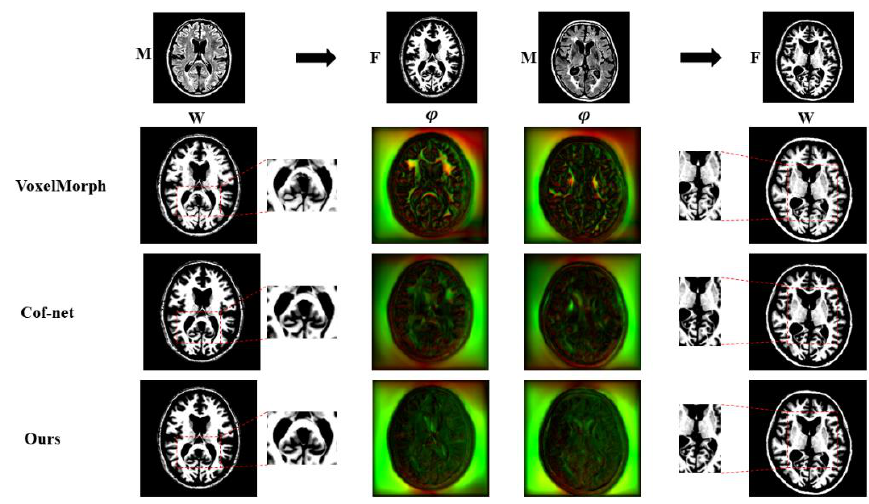
Figure 10. Experimental results on the MRbrain dataset.